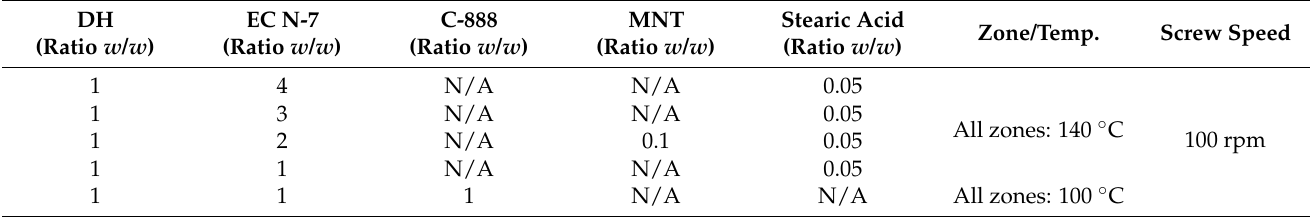
Table 2. Formulation compositions and processing parameters for ethyl cellulose N7 (EC-N7) with/without a lipid carrier.